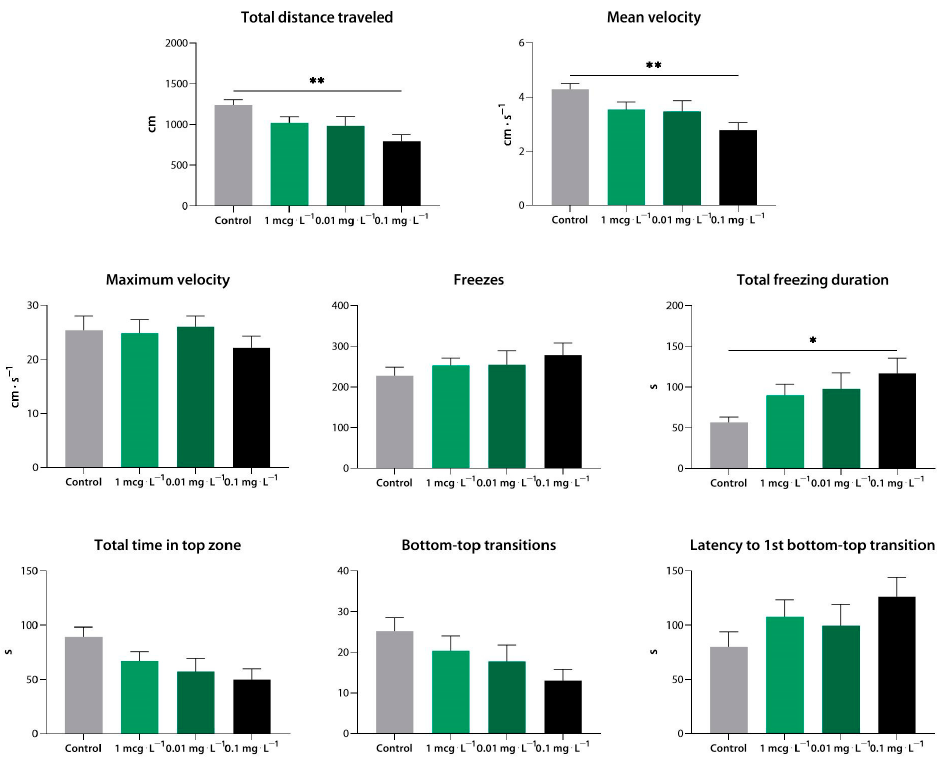
Figure 6. Compound 5 ( 33b ) induces sedation in zebrafish at a range of concentrations, as assessed using the novel tank test. *, p < 0.05; **, p < 0.01.